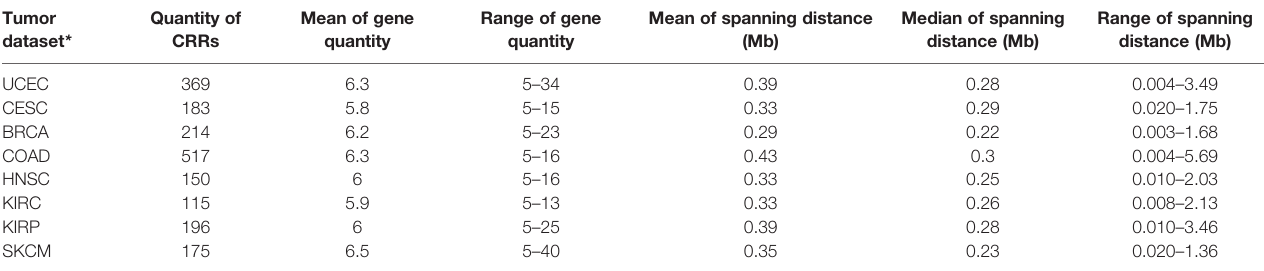
TABLE 1 | Characteristics of CRRs obtained from different tumor